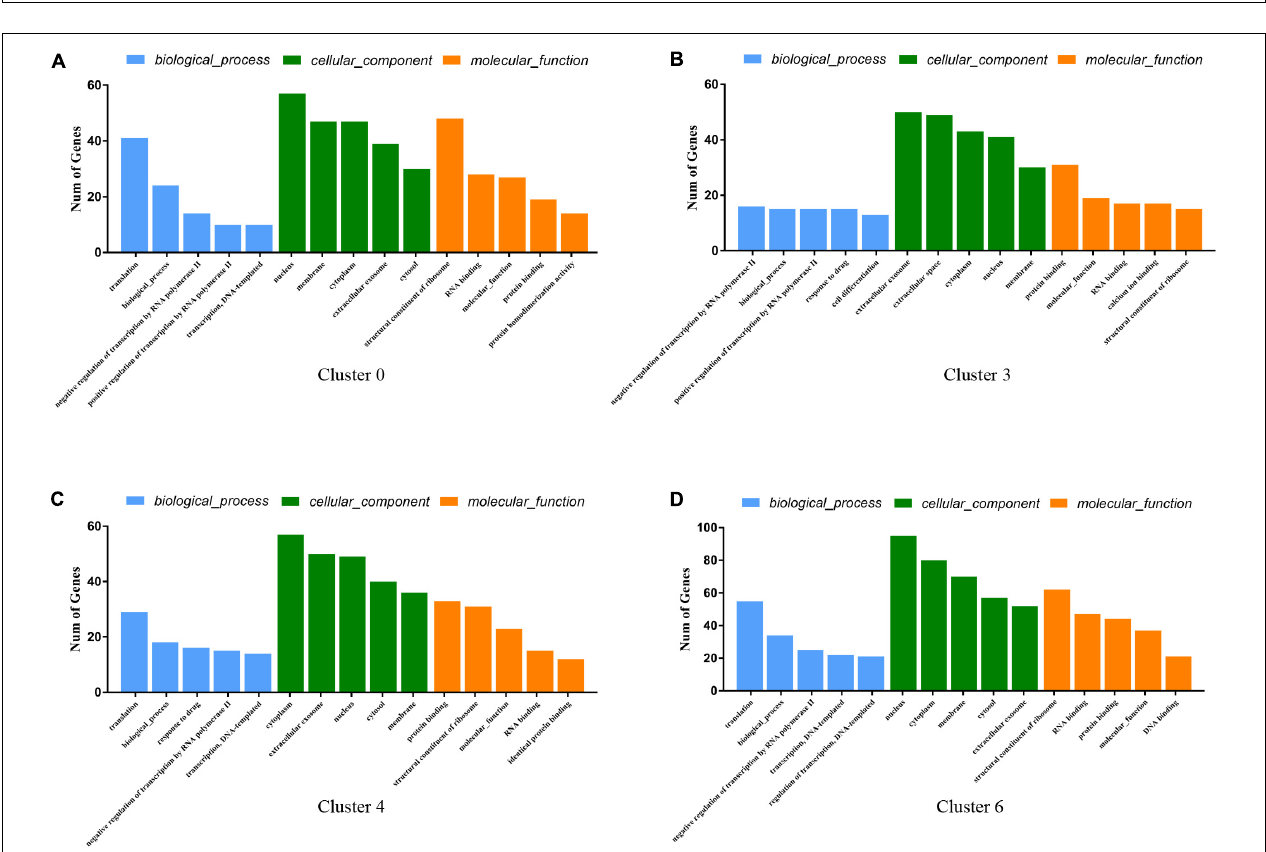
FIGURE 5 | Violin plots showing select genes that are deferentially expressed in the decreased clusters of 0, 3, 4, 6, and 8. Y -axis, log-normalized transcript counts.